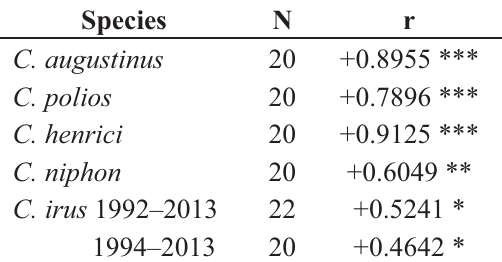
Table 10. Spearman rank correlation coefficients (r) of N days in flight span per year and N individuals recorded at all sites (not just long-term sites) on all surveys in central Wisconsin that year, by species. * p < 0.05, ** p < 0.01, *** p <